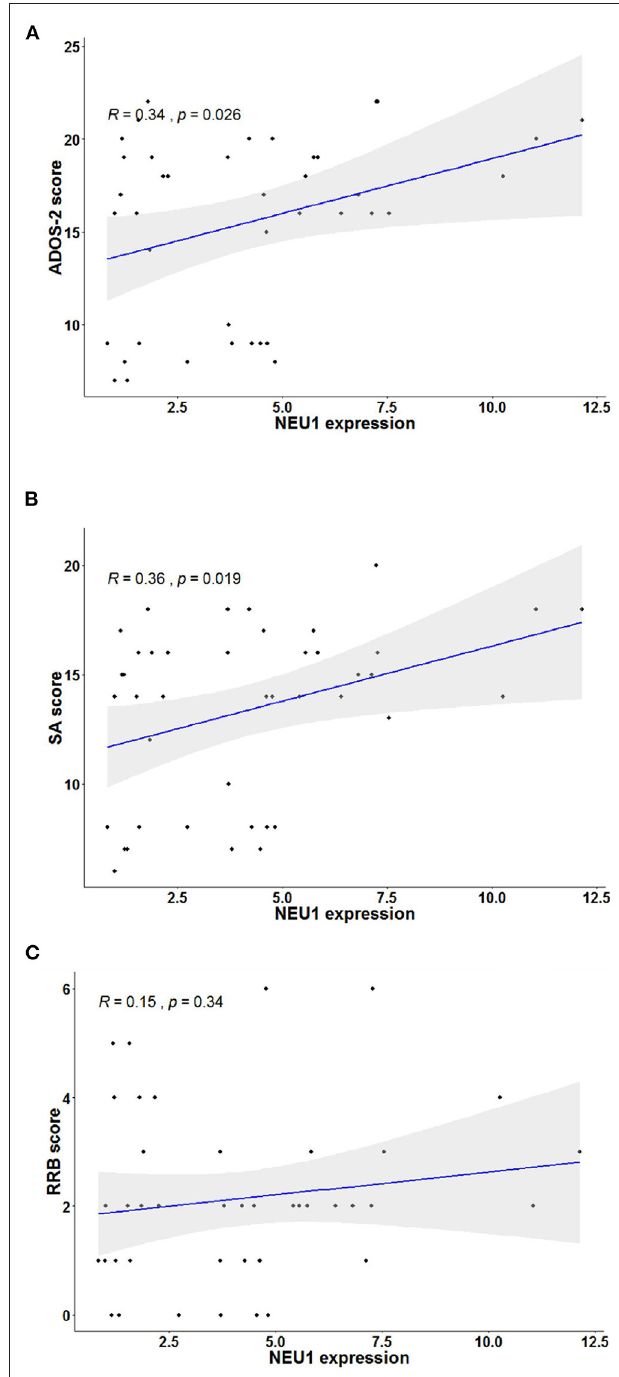
FIGURE 3 | Correlation analysis in children with ASD’s blood NEU1 expression with ADOS-2, SA, and RRB scores. Statistical calculation of correlation was performed on each pair to obtain the Pearson correlation result, and the sig two-tailed probability P -value < 0.05 represented correlation. (A) Correlation of NEU1 gene expression results with ADOS-2 score. (B) Correlation of NEU1 gene expression results with SA score. (C) Correlation of NEU1 gene expression results with RRB score. (A,B) show that the elevated expression of NEU1 was positively correlated with ADOS-2 and SA. (C) shows that no correlation was found with the RRB score.